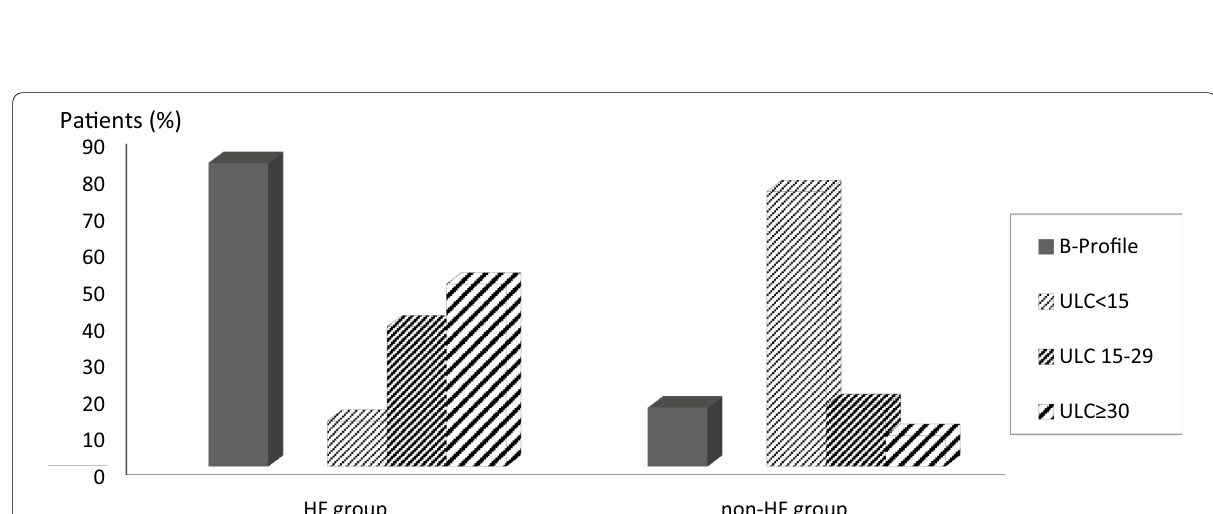
Fig. 4 Distribution of B-profile pattern and ultrasound lung comets (ULC) score between the heart failure (HF) and non-HF groups. *p < 0.001 between HF and non-HF groups for B-profile pattern ; **p value < 0.001 between HF and non-HF groups for ULC